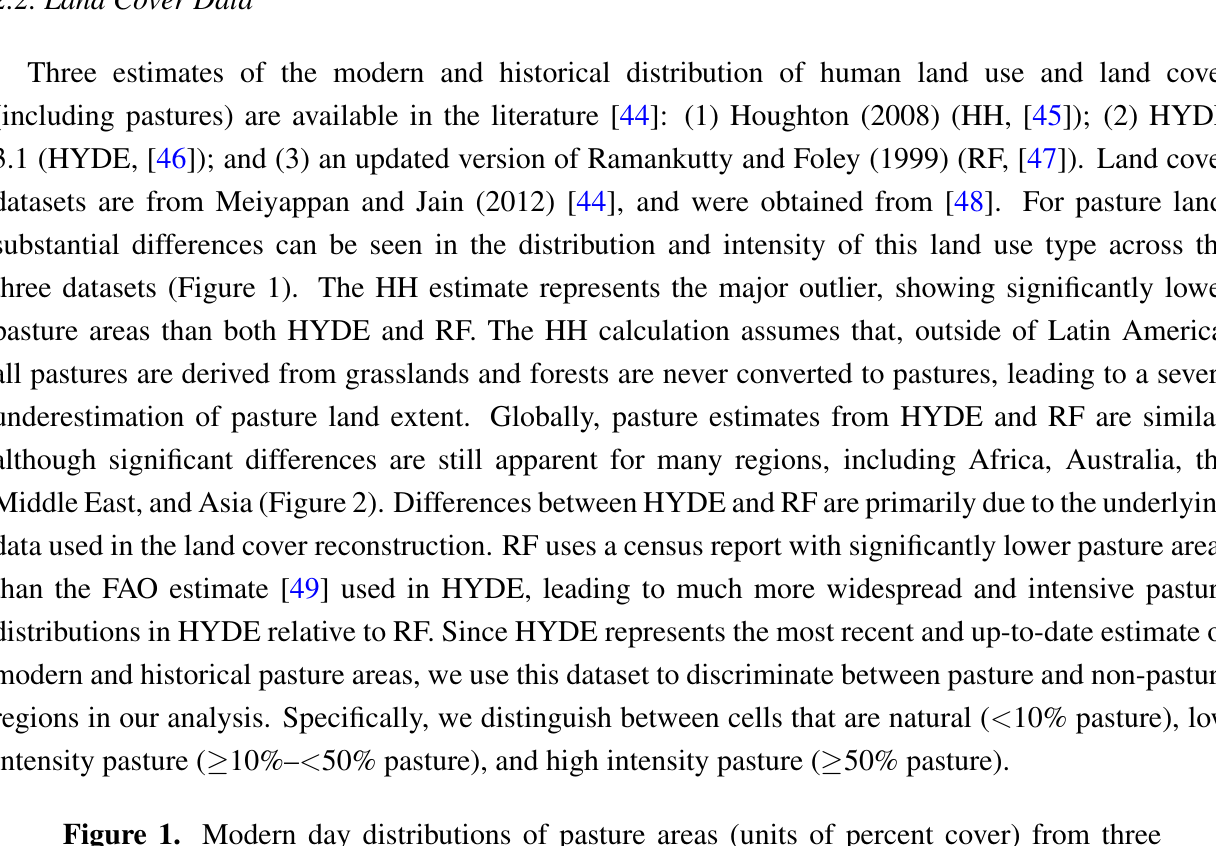
different land cover datasets: ( a ) HH [45]); ( b ) HYDE [46]; and ( c ) RF (updated from